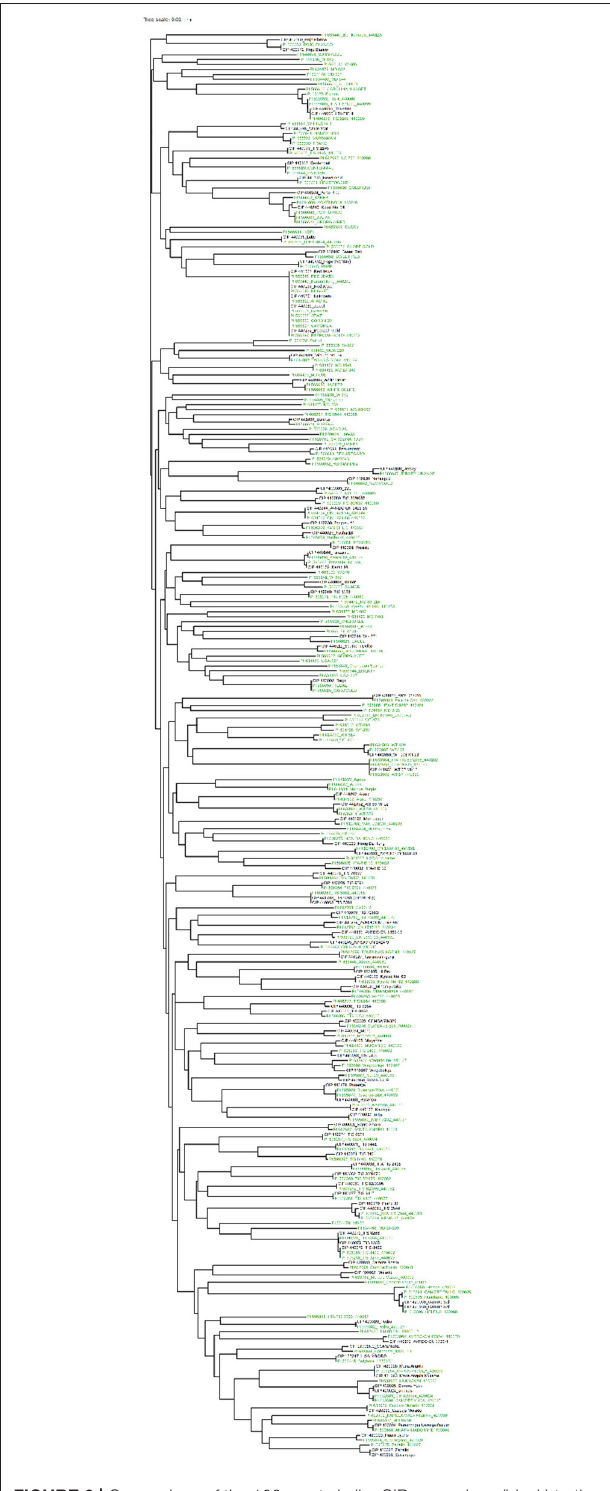
FIGURE 6 | Comparison of the 100 most similar CIP accessions (black) to the 189 USDA (green) accessions. The phylogeny was created from calculating a pairwise genetic similarity distance matrix and subsequently employing neighbor-joining to construct the intraspecific relationships. iTOL was employed to color code